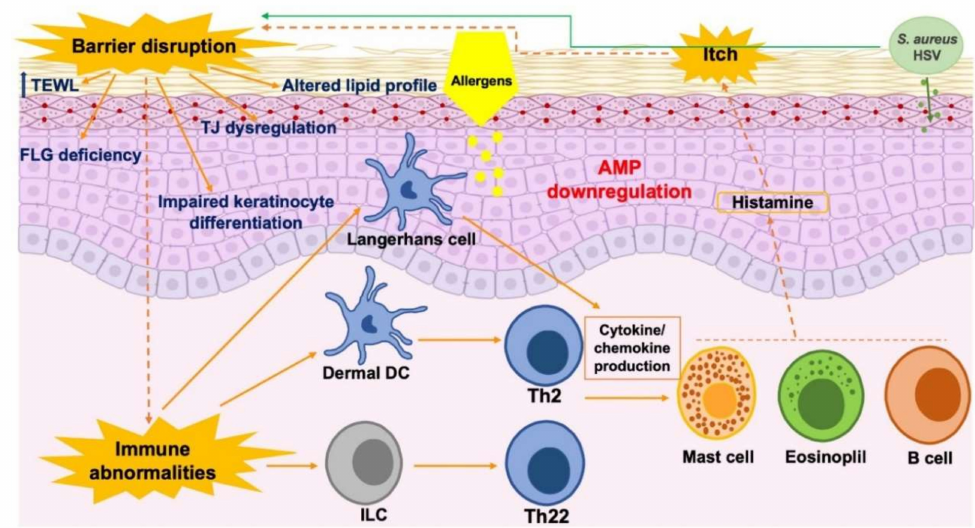
Figure 2. Pathogenic factors of AD and their interactions in skin lesions. AMP: antimicrobial peptide; DC: dendritic cell; FLG: filaggrin; HSV: herpes simplex virus; ILC: innate lymphoid cell; TEWL: transepidermal water loss; Th: T-helper cell; TJ: tight